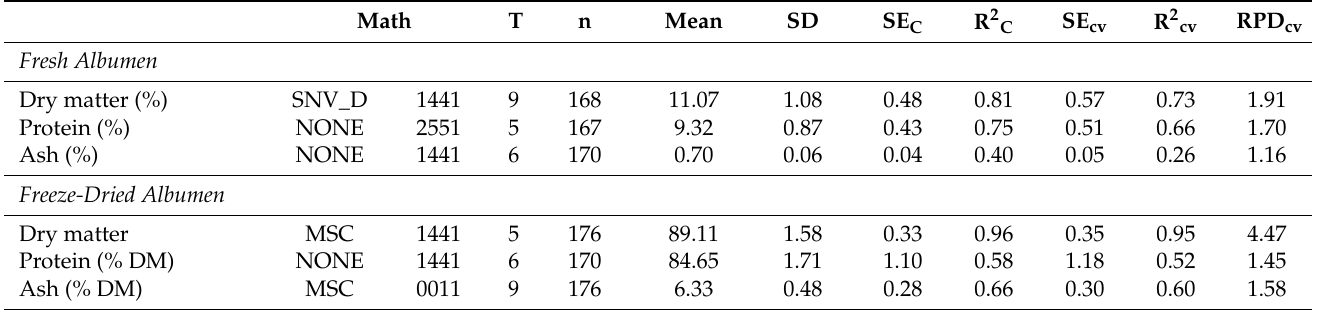
Table 3. Calibration and cross-validation statistics for modified partial least-squares regression models developed to predict the composition of fresh and freeze-dried